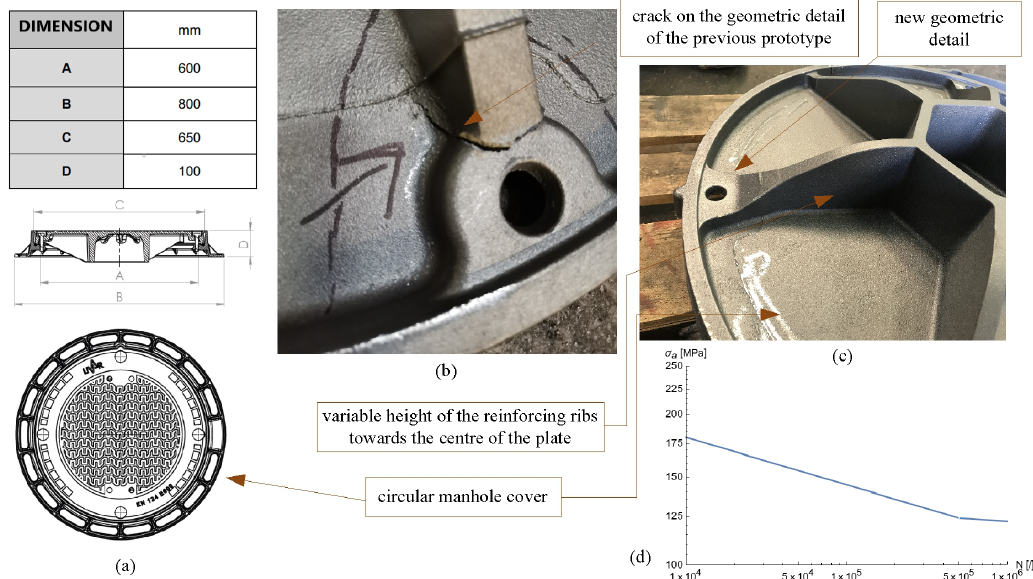
Figure 1. ( a ) Dimensions of the manhole cover [19]; ( b ) a failure detected on the previous cover prototype; ( c ) the improved geometry of the manhole cover; ( d ) durability curve of ductile iron grade EN-GJS-500-7